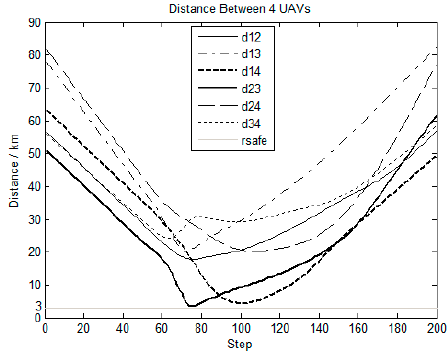
Figure 13. Distance between UAVs.